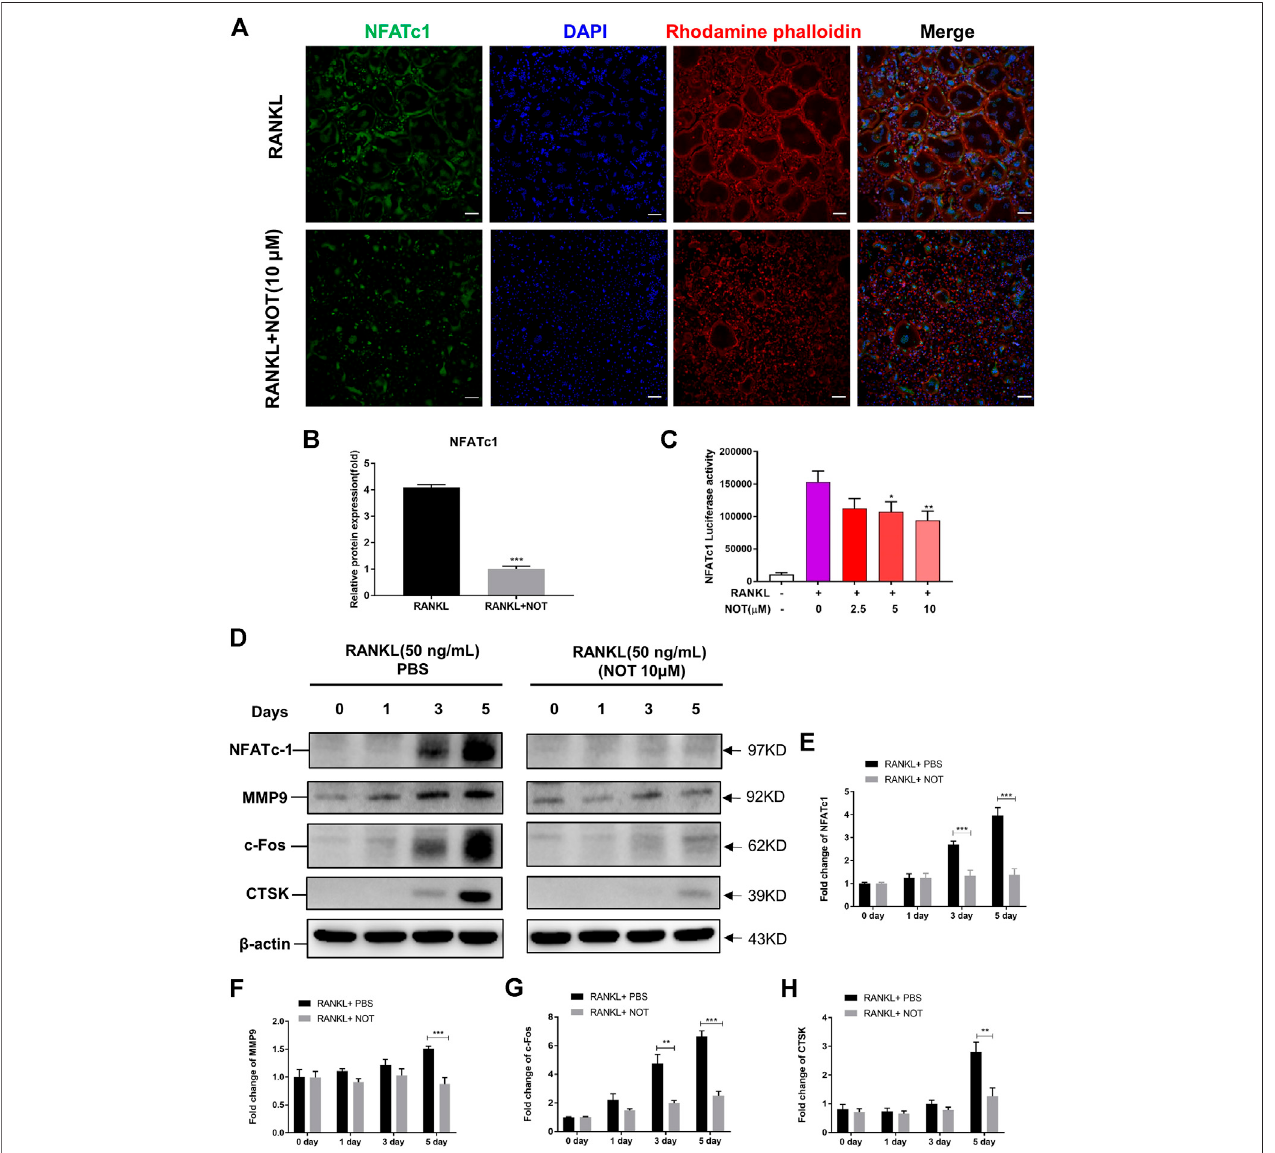
FIGURE 3 | Notopterol abrogates RANKL-induced NFATc1 activation and associated downstream protein expression. (A,B) Representative confocal images (A) and quanti fi cation analysis (B) indicated that NFATc1 protein expression activated by RANKL was strikingly hampered by Notopterol. Scale bar (cid:2) 200 μ m. (C) RAW 264.7 cells transfected with an NFATc1 luciferase construct were pre-treated with indicated concentrations of Notopterol, followed by RANKL (50 ng/ml) stimulation for 24 h. NFATc1 luciferase activity was measured with a luciferase reporter assay system. (D) Representative images of Western blotting re fl ecting the effects of Notopterol on NFATc1, MMP9, c-Fos, CTSK induced by RANKL. (E – H) The ratios of band intensity of NFATc1 (E) , MMP9 (F) , c-Fos (G) , CTSK (H) relative to β -actin were quantitatively determined. “ − ” means RANKL untreated; “ + ” means RANKL treated. Data are presented as mean ± SEM. All in vitro experiments were repeated three times with similar results. Signi fi cant differences between the control and treatment groups are shown as * p < 0.05, ** p < 0.01 and *** p < 0.001.